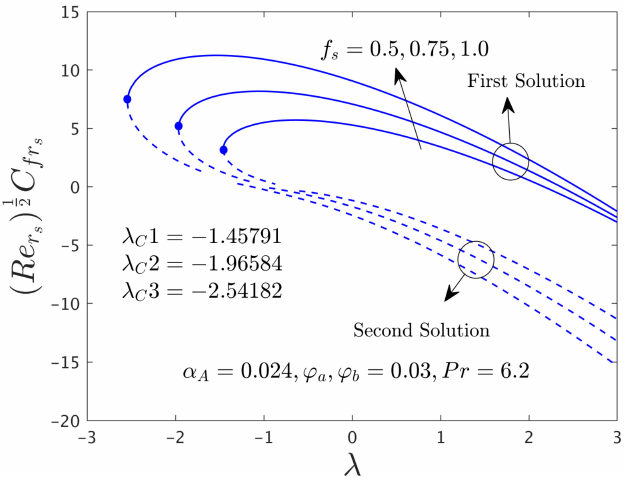
C fr against λ for numerous choices of f s s s